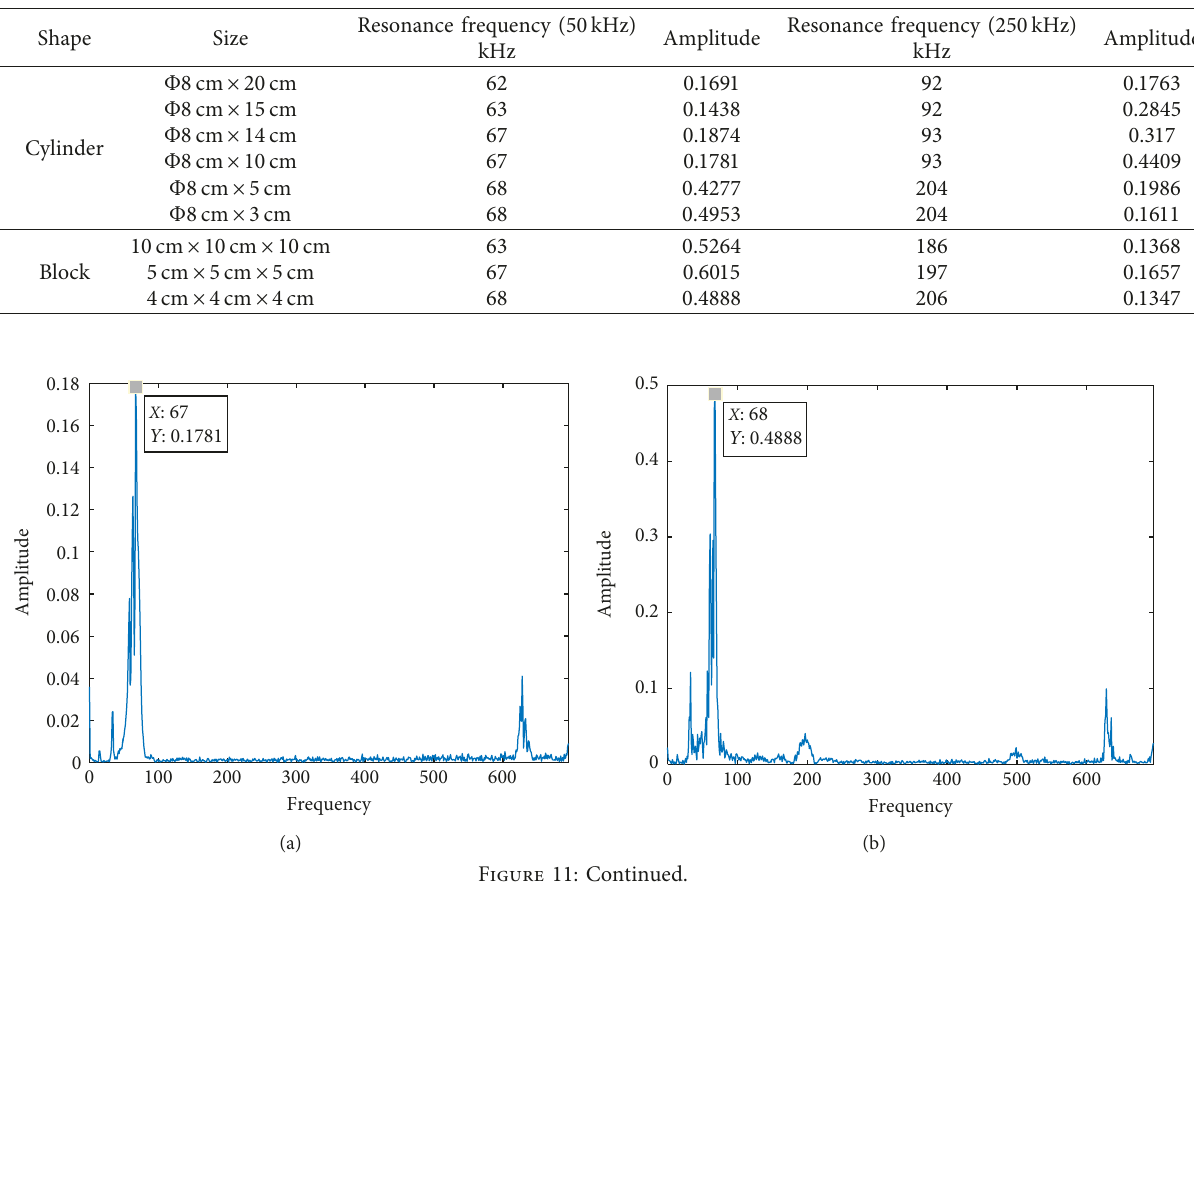
Figure 10: Signal processing of ultrasonic test. Table 2: Ultrasonic test results of sandstone cores.